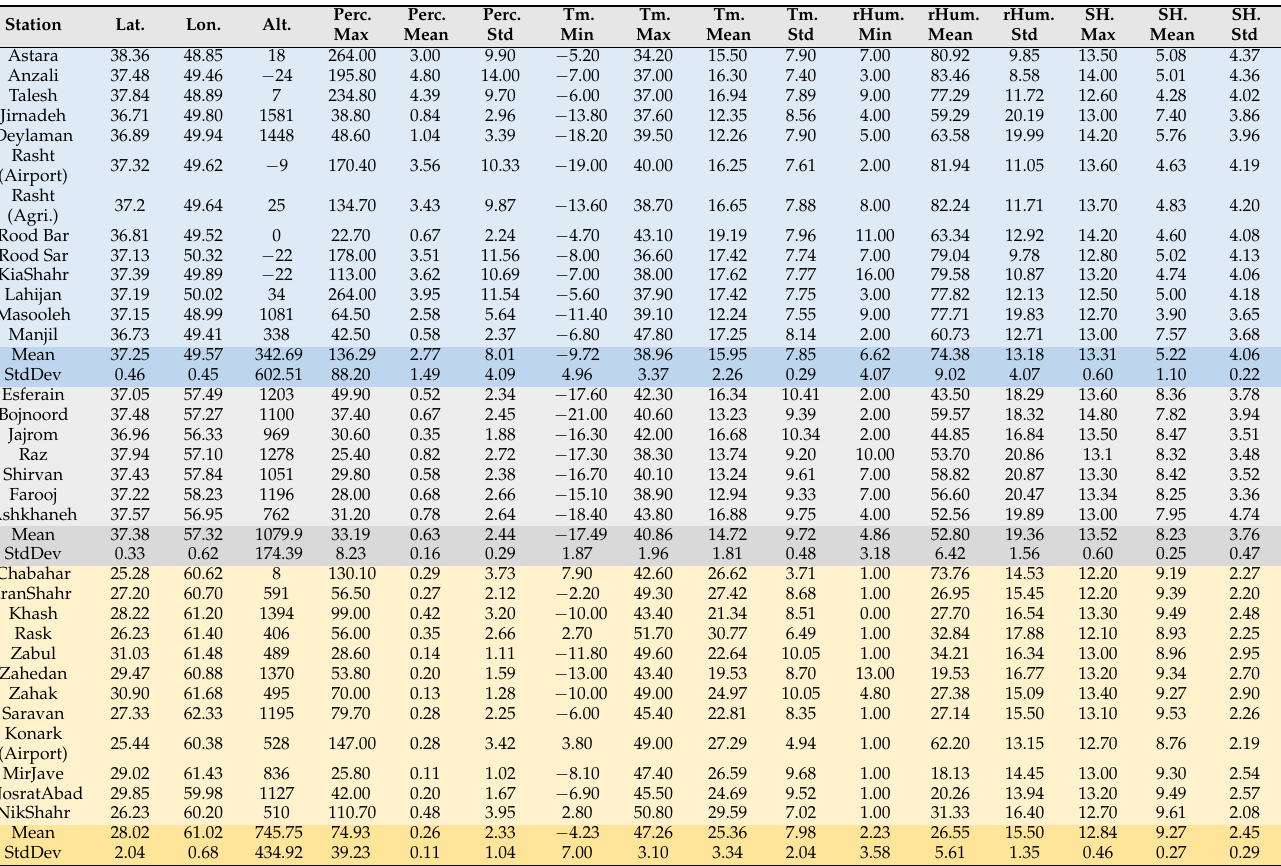
Table 1. Characteristics of synoptic ground stations in study areas from 1998 to 2017 (collected from are in the rainy region, gray and yellow rows are in the semi-arid and arid regions, respectively.